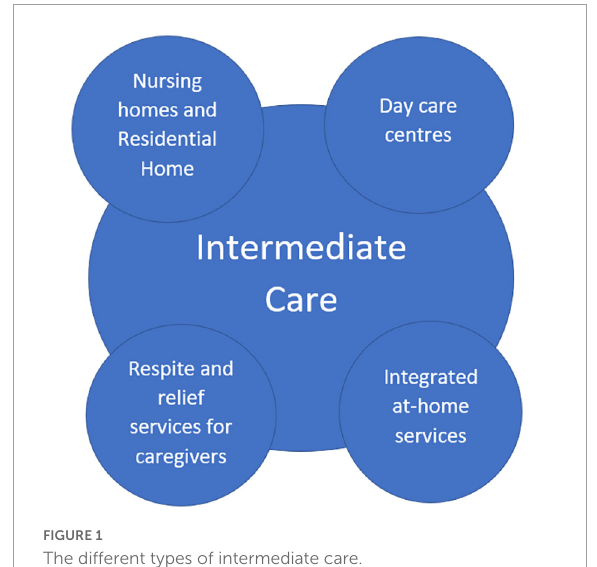
FIGURE1 The different types of intermediate